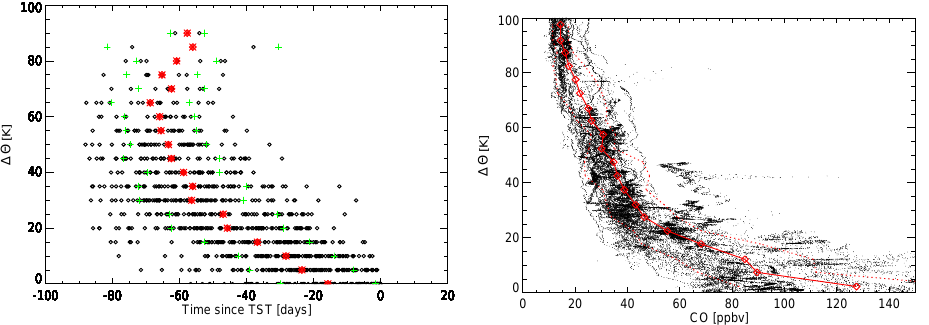
Fig. 11. Left: Profiles of transit times since last tropopause crossing as a function of potential temperature relative to the 2 PVU surface ( ∆Θ for latitudes > 45 ◦ N over Europe (20 ◦ W–10 ◦ E). Red symbols indicate the mean, green the 1- σ standard deviation about the mean. Right: CO profiles over Europe as measured from various aircraft campaigns between 1998 and 2004. Red lines indicate the mean, dashed: 1- σ standard deviation. Both plots are for winter conditions over Europe. measurements we focus on the European sector as defined in Fig. 11. For each grid point where a trajectory was initial- ized, we plotted the vertical profile of the times since TST ( t TST ) in the same way as in Hoor et al. (2004) using 12 as vertical coordinate. The resulting distribution is shown in Fig. 11, where each black dot indicates the transit time of an individual TST-trajectory. Although a large variation of transit times at a given 12 level is found, an increase with larger distances from the tropopause is evident. Moreover, the mean transit time shows a “kink” at 12 = 30 K, which is very similar to the observation during SPURT (compare Fig. 6b in Hoor et al.,